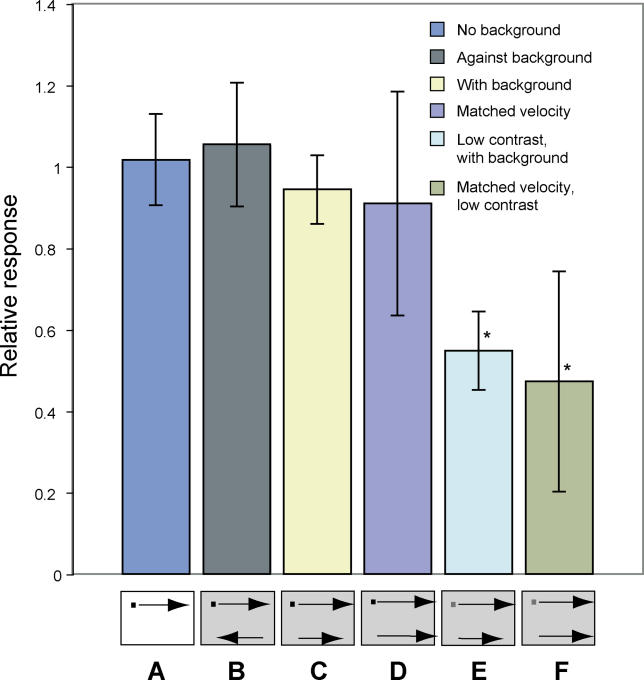
Summary of Data from Five Classes of STMDs (including Type 1 and 2) to Target Motion in the Preferred DirectionResponses were estimated from the period during which the target was within the receptive field and normalized to a control (A) in which no background was present (error bars are 95% confidence limits). Responses to targets presented against moving backgrounds were independent of the speed and direction of the background ([B–D] corresponding toFigure 5B–5D), although variance increases if background speed is matched to the target (D). Significant reductions (*) in response were observed when target contrast was reduced either with a speed differential ([E]t = 13.2755,p < 0.001) or with matched speed ([F]t = 6.0156,p < 0.05).